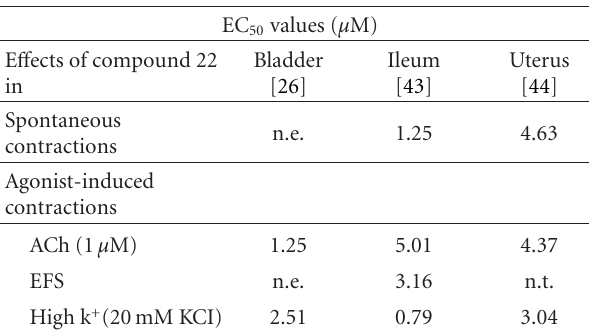
Table 1: EC 50 values (concentration producing 50% of maximum inhibition of spontaneous or agonist-induced contractions) of compound 22 in the isolated bladder, ileum and